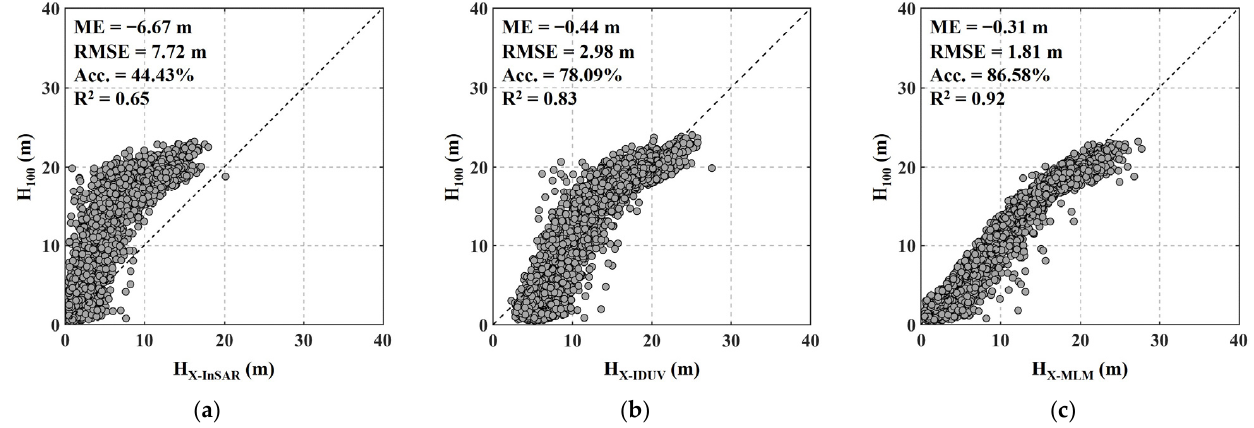
Figure 17. Accuracy evaluation of forest height estimation results: ( a ) H X-InSAR; ( b ) H X-IDUV; ( c ) H X-MLM .